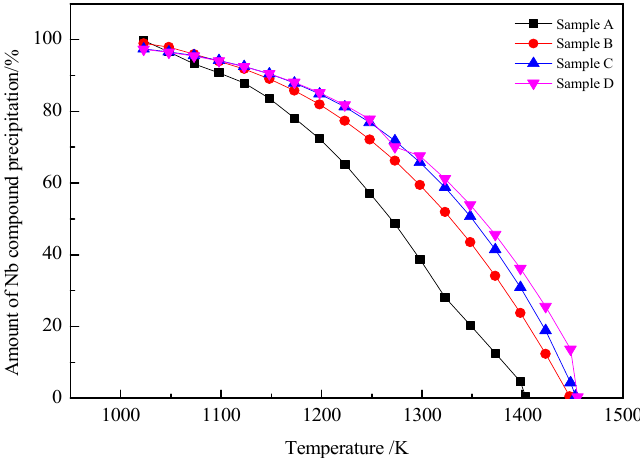
Figure 9. The relationship between the precipitation amount of Nb and temperature. Although the content of Nb in samples A, B, C and D is different, at 1023 K, the precipitation amount of Nb compounds is 99.78%, 98.97%, 97.47% and 97.34%, respectively, almost all of which are precipitated. The increase in Nb content increases the initial pre ‐ cipitation temperature of Nb compounds (the initial precipitation temperatures of samples A, B, C and D are 1403 K, 1447 K, 1453 K and 1455 K, respectively). At the same temperature, the increase in Nb content promotes the precipitation of Nb compounds.